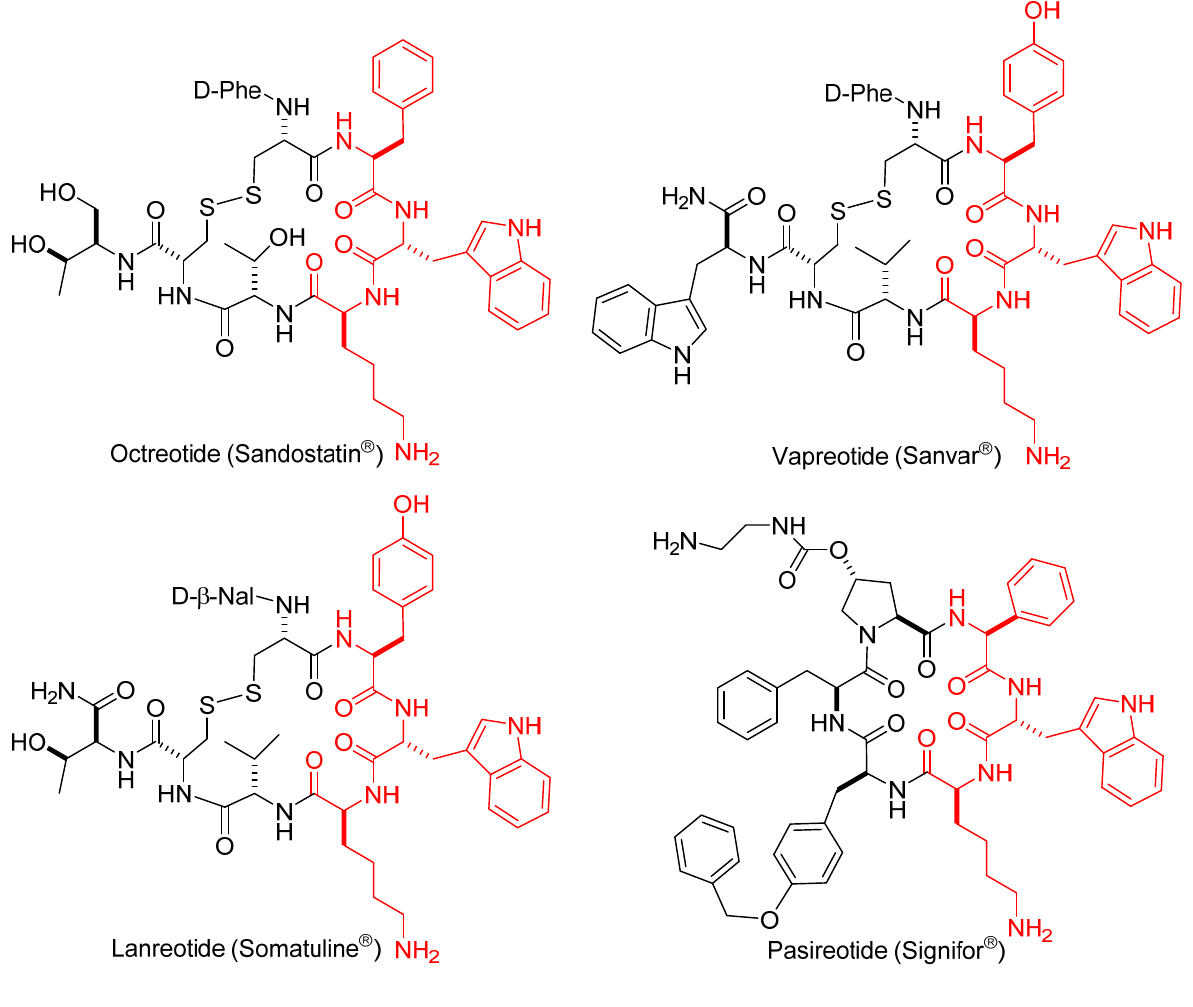
Figure 2. Amino acid sequences of the marketed short-ring